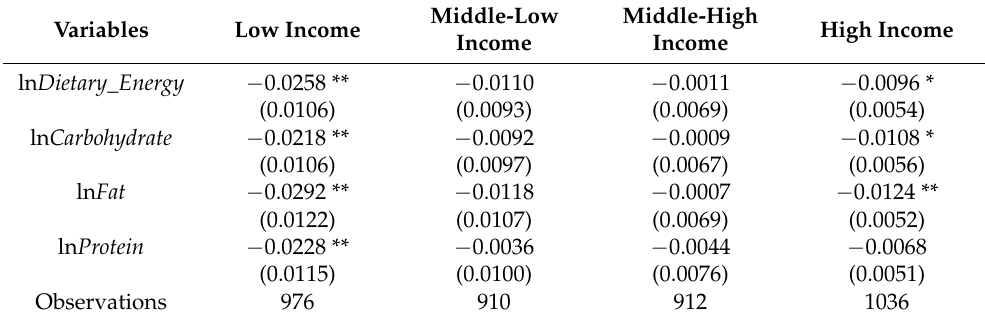
Table 7. Estimation results of the COVID-19 impact on nutritional intake by income